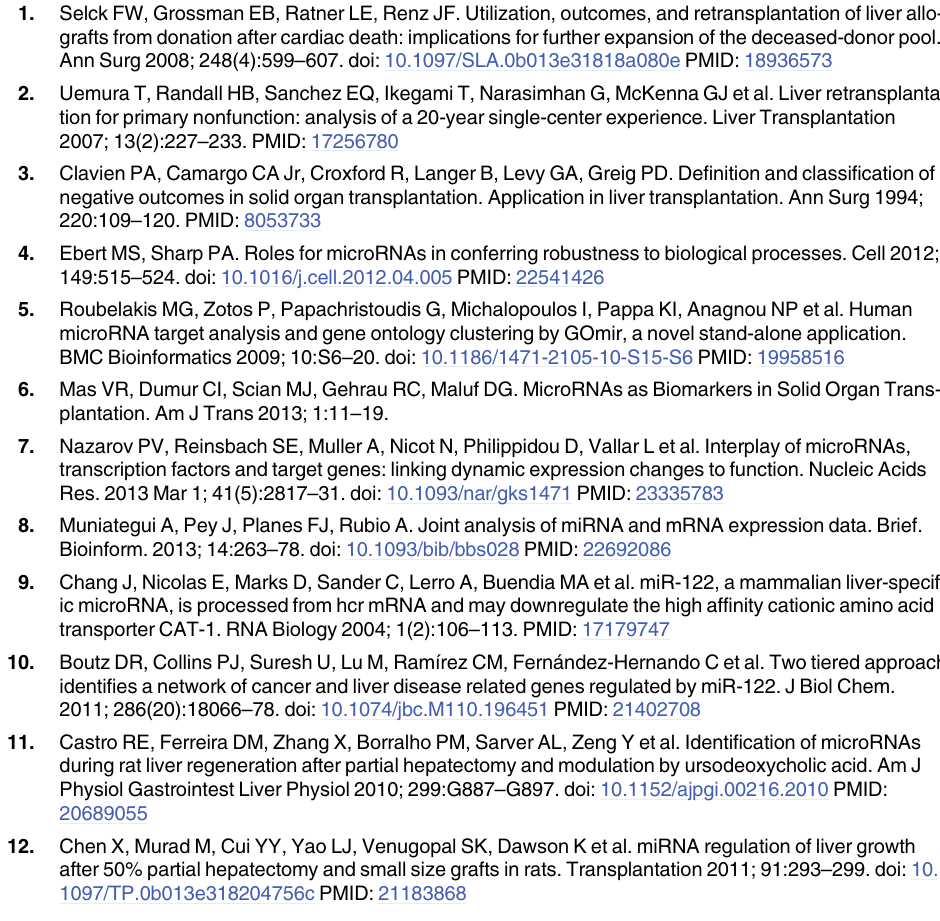
S2 Table. Predicted targets of microRNA 22. Summary of genes and pathways affected by a microRNA 22 using the prediction software of DIANA-TarBase 6.0 (microT-4) for KEGG (Kyoto Encyclopedia of Genes and Genomes) pathways